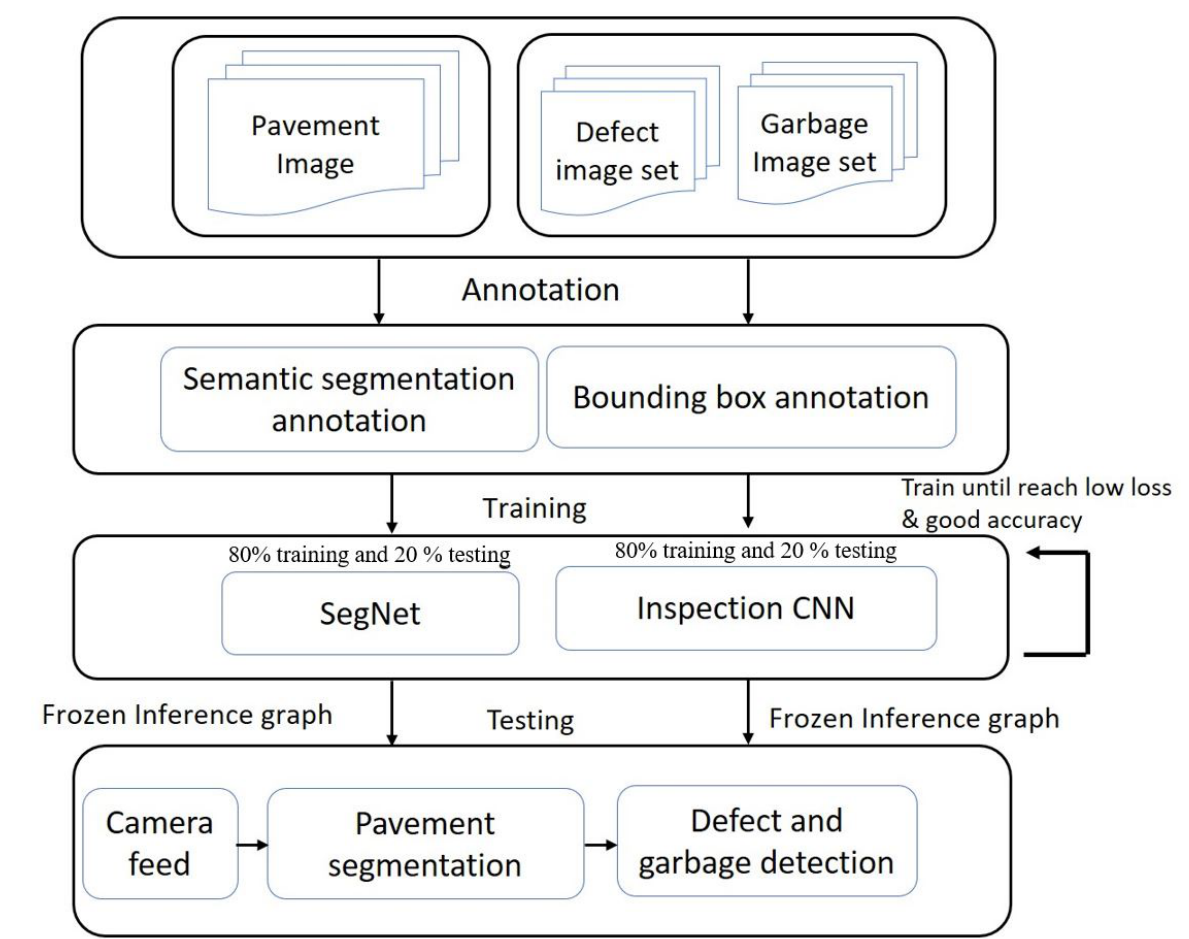
Figure 9. Flow diagram for training the pavement inspection framework.